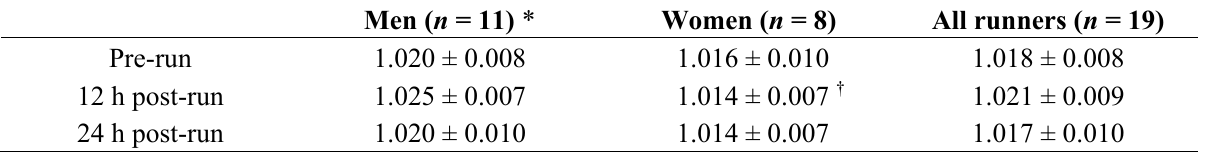
Table 1. Urine specific gravity kinetics (mean ±